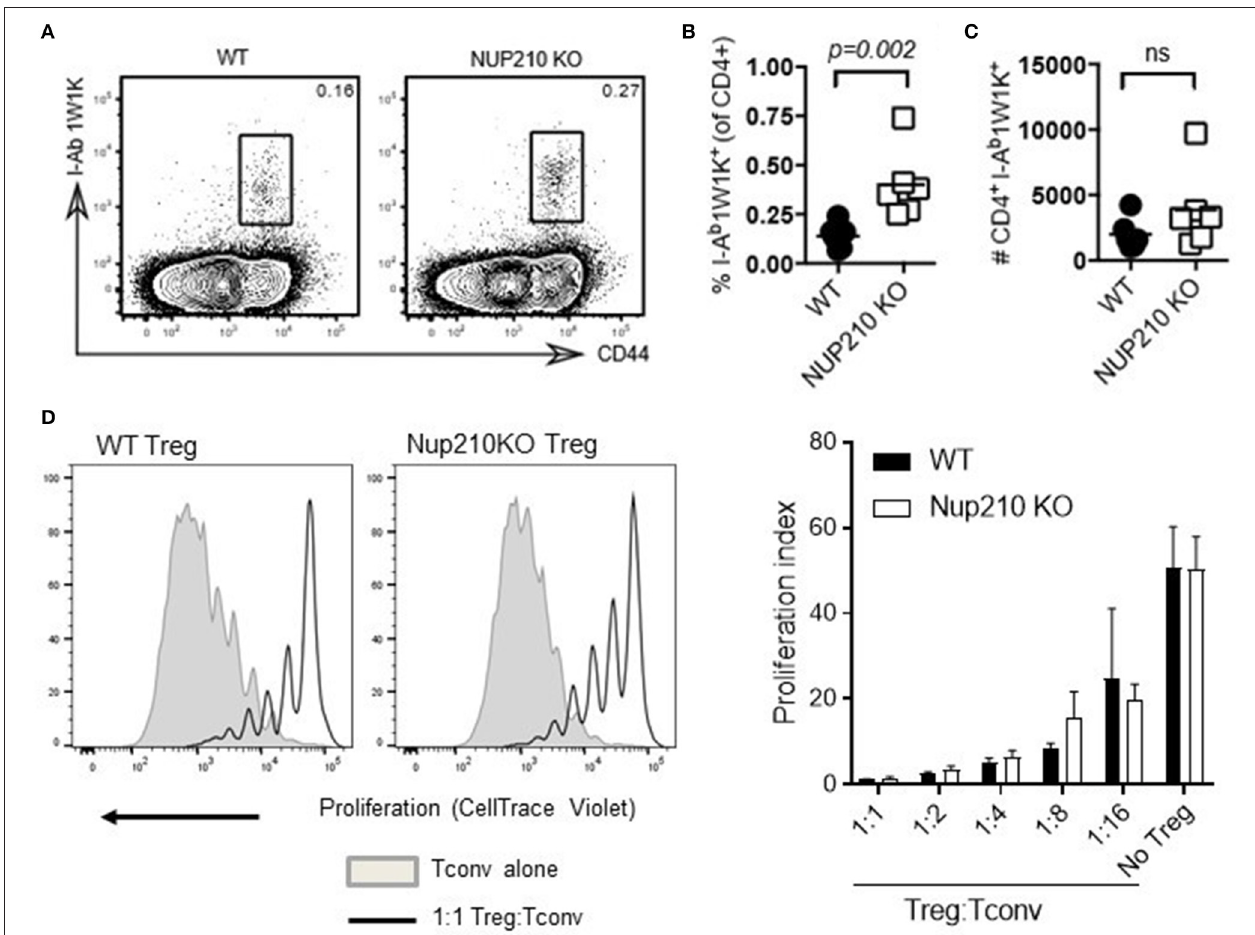
FIGURE 5 | Nup210-deficient T cells exhibit intact immunogenic and tolerogenic properties. (A) WT and Nup210 KO mice were immunized subcutaneously with 1W1K peptide emulsified in IFA and the generation of I-A b 1W1K-specific CD4 + T cells was determined 8 days later by tetramer staining. Representative flow cytometry profiles of I-A b 1W1K tetramer and CD44 staining, gated on CD4 + T cells. These data were used to determine the proportion (B) and number (C) of I-A b 1W1K-specific CD4 + T cells. Data are representative of one experiment with 6 mice per group; each data point represents an individual animal. Statistical significance was determined using a Mann-Whitney rank test; exact p -values are shown for significant differences. (D) CD4 + CD25 + regulatory T cells were sorted from wildtype and Nup210KO mice and incubated at increasing ratios with wildtype naïve CD4T cells (Tconv). Representative CellTrace Violet dilution histograms are shown (left), along with the proliferation index (right), a measure of the median number of